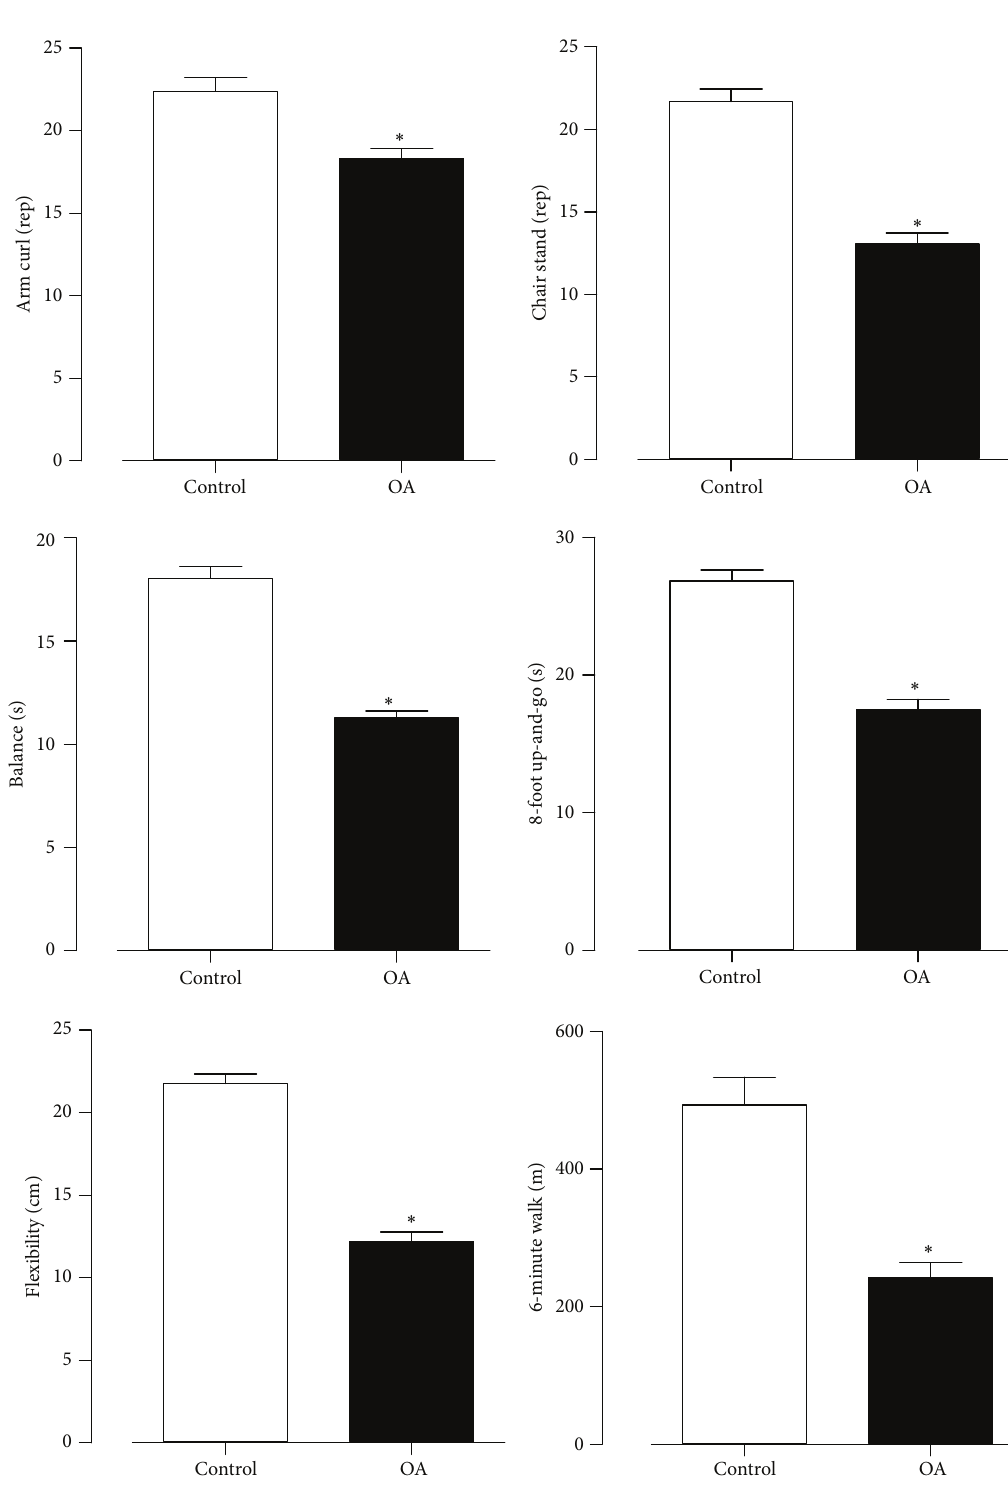
Figure 1: Values expressed in ± SEM of functional fitness test of control and osteoarthrosis (OA) groups. ∗ 𝑃 < 0.05